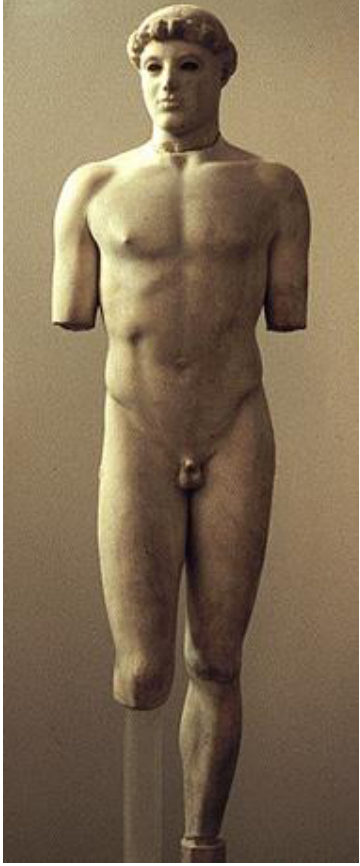
Figure 2. Kritios Boy , c. 480 BC. Marble, 82 cm. Acropolis Museum ,